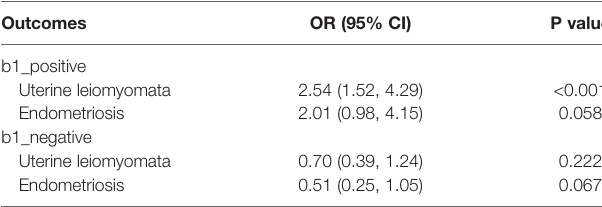
( Figure 1 , Table S2 ). After adjusting for covariates that were different between groups, equol was found signi fi cantly associated with uterine leiomyomata (OR: 1.23, 95% CI: 1.07-